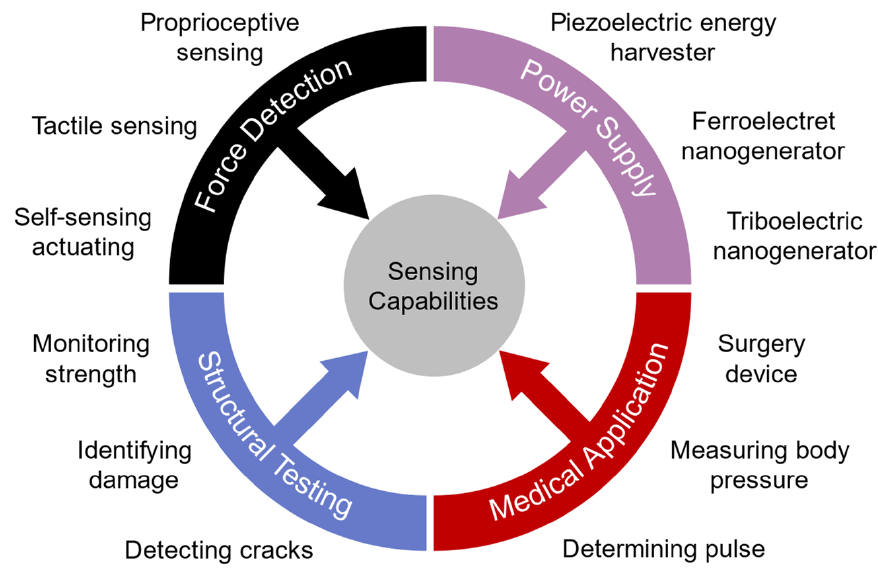
Figure 8. Categories of piezoelectric sensing applications that can be used in microrobots.